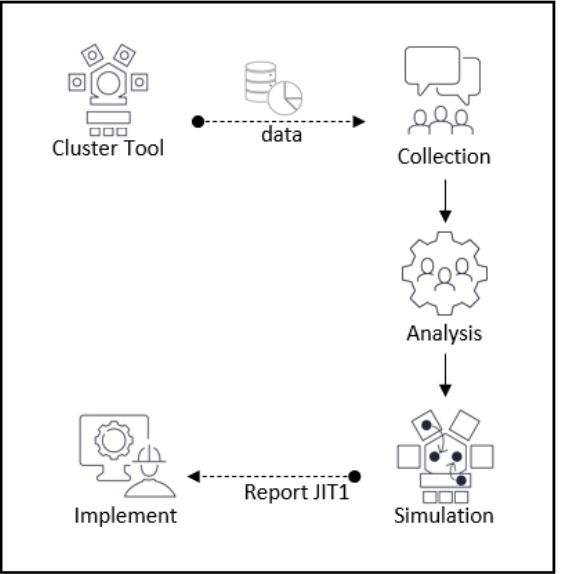
Figure 4. JIT1 optimization of semiconductor cluster tool